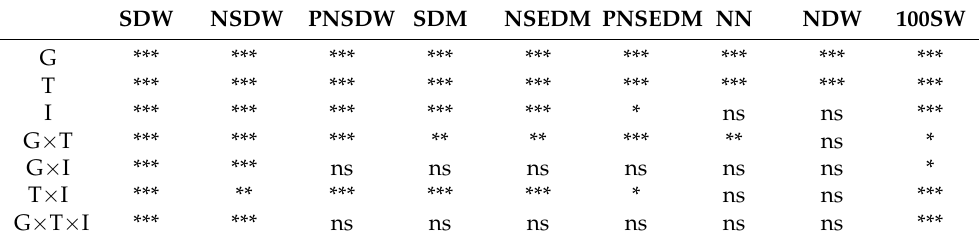
Table 4. Analysis of variance in the field experiment, with genotypes (G), treatments (T), strains (I), genotype treatment interaction (G × T), genotype strain interaction (G × I), treatment strain interaction (T × I), and genotype treatment strain interaction (G × T ×